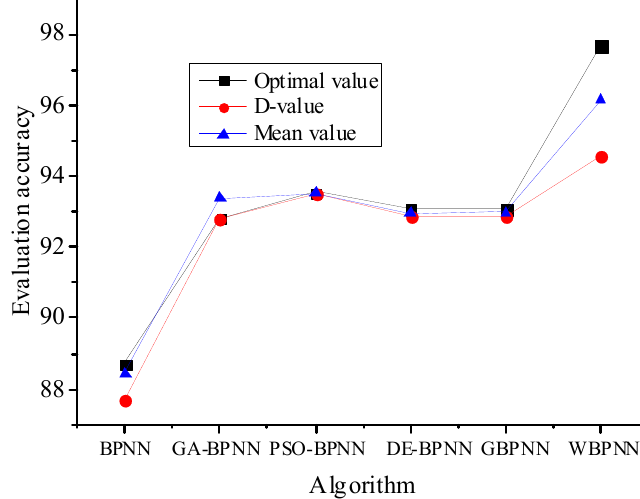
Figure 8. Statistical results of water prediction based on the prediction evaluation accuracy.